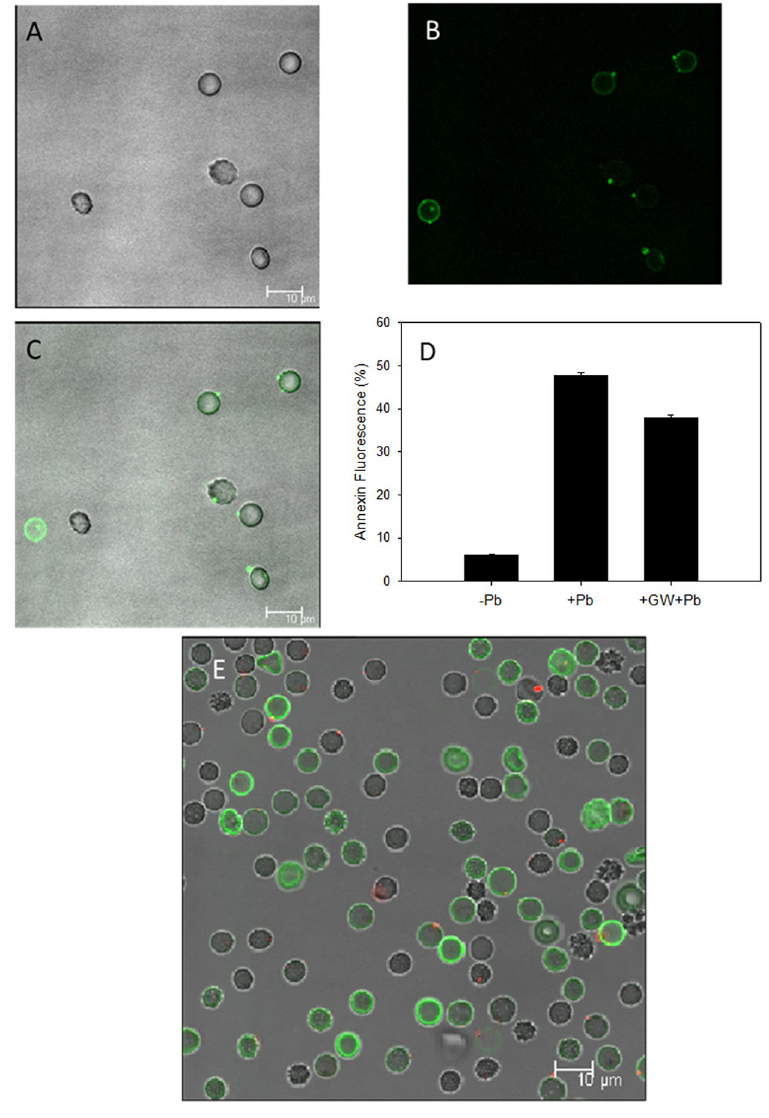
Figure 9. Confocal microscopy visualization of PS exposure after 20 min Pb 2 + incubation. Annexin V was used to detect PS translocation and detected by fluorescence (green). Transmitted light ( A ), fluorescence ( B ) and mix of both images ( C ). Percentage of cells that expose PS using FACS (three different experiments, 10000 cells per experiment) ( D ). RBC treated with both annexin V and antiCer (Alexa Fluor 633 as secondary antibody) ( E ). Images in C and E are a combination of transmitted light and fluorescence confocal microscopy, where red dots indicate ceramide-enriched zones detected by the antiCer antibody as in Fig.